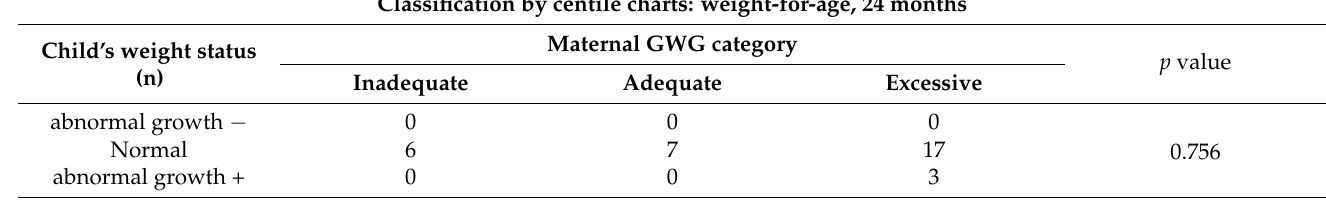
Classification by centile charts: BMI-for-age, 12 months